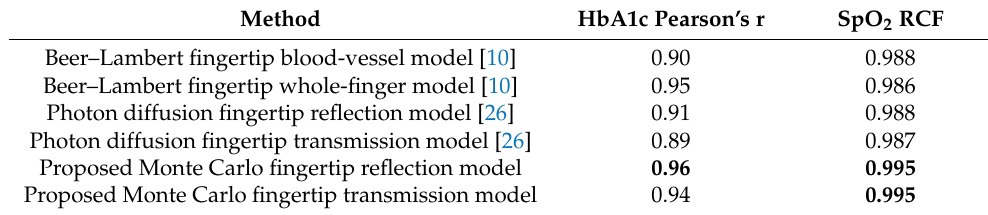
Table 10. Comparison of the different methods for estimating HbA1c in vivo,